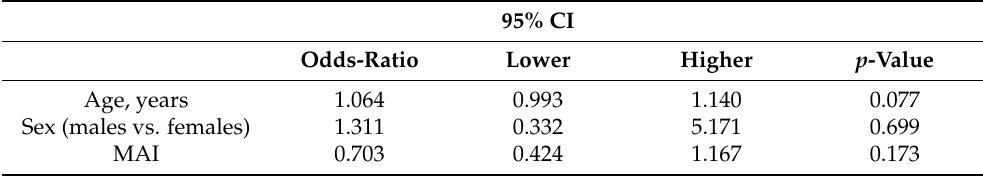
Table 5. Multivariate logistic regression of predictors of cardiovascular